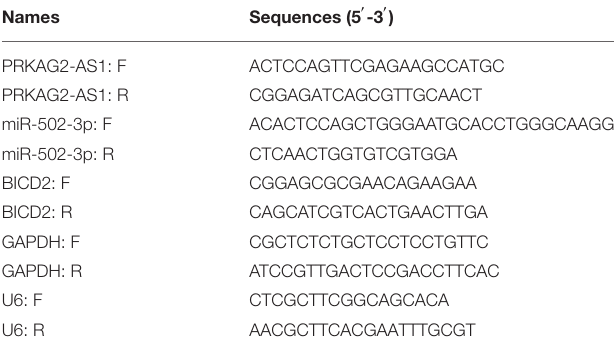
TABLE 1 | The primer sequences utilized in this study for